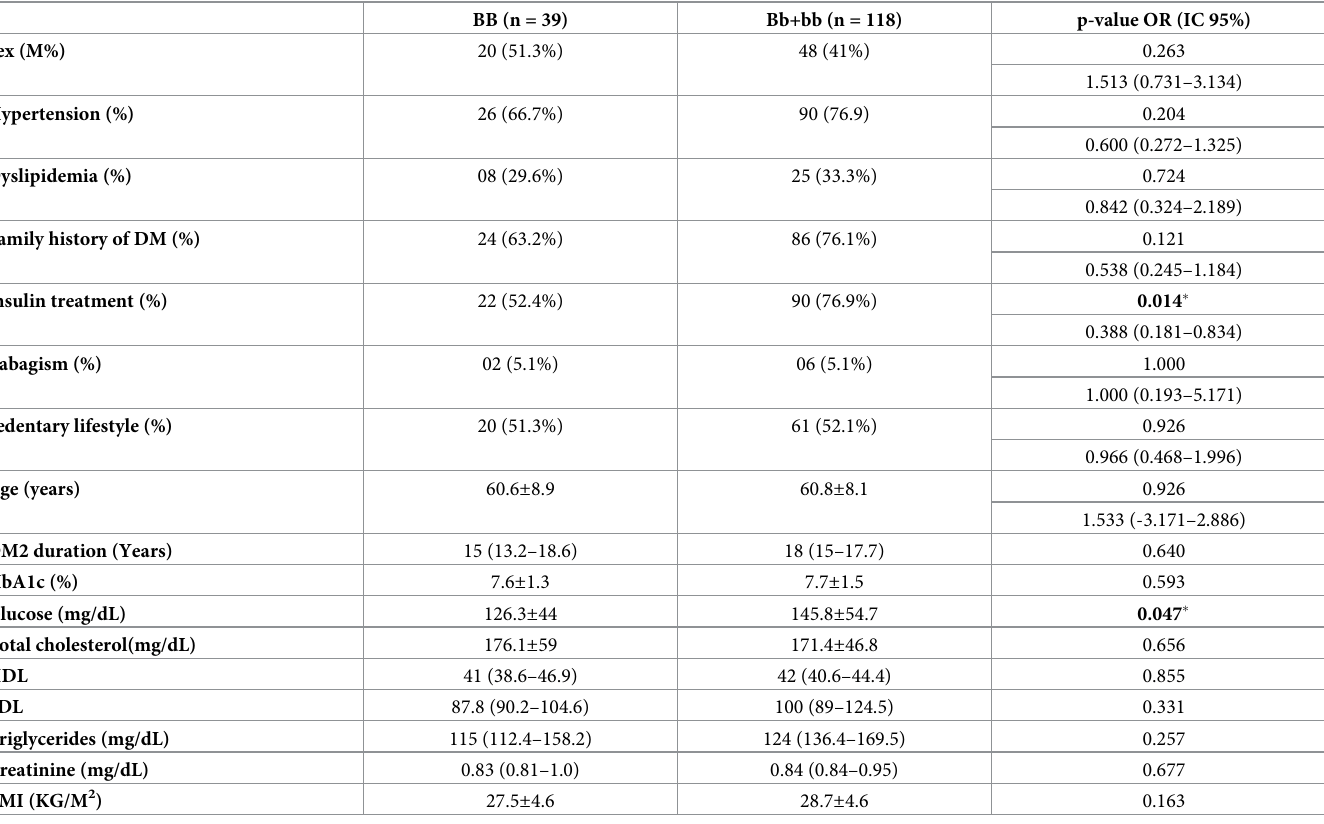
Table 3. Clinical, biochemical and metabolic parameters of the RD group according to rs1544410 genotypes.